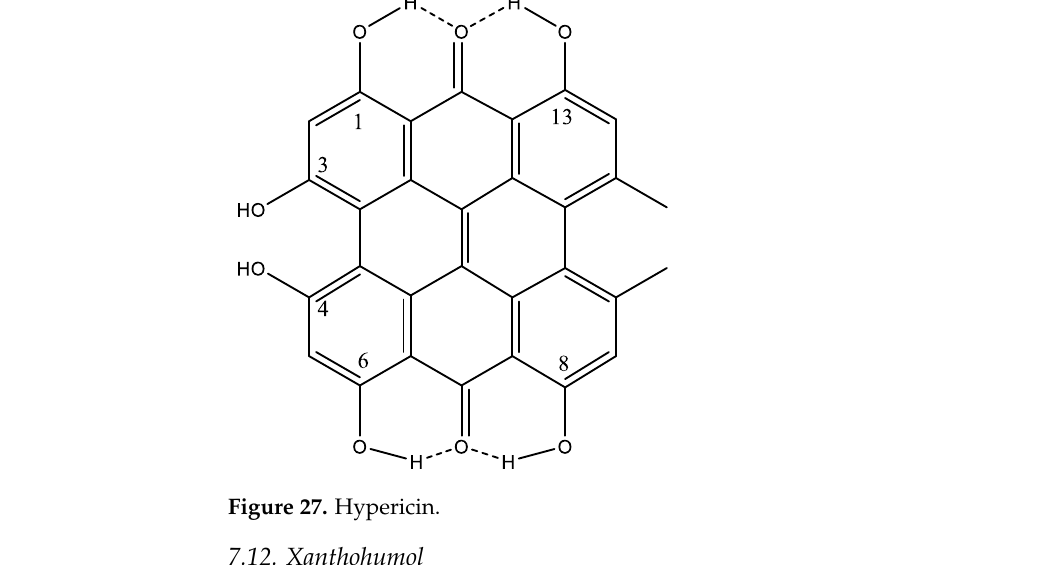
17 of 25 Figure 26. Muscimol. 7.11. Hypericin Hypericin is isolated from St. John ’ s wort and is a powerful natural photosensitizer used in photodynamic therapy [101]. Hypericin is a typical system with two hydrogen bond donors to the same acceptor (see Figure 27). The proton chemical shift of OH-1,6 is 14.8 ppm and that of OH-8,13, is 14.2 ppm. For pseudohypericin, similar values were ob- tained [102]. For the bay protons (OH-3,4) in acetone, the OH chemical shifts are reported as 11.6 ppm. DFT calculations have been used to confirm the structure in acetone [103].